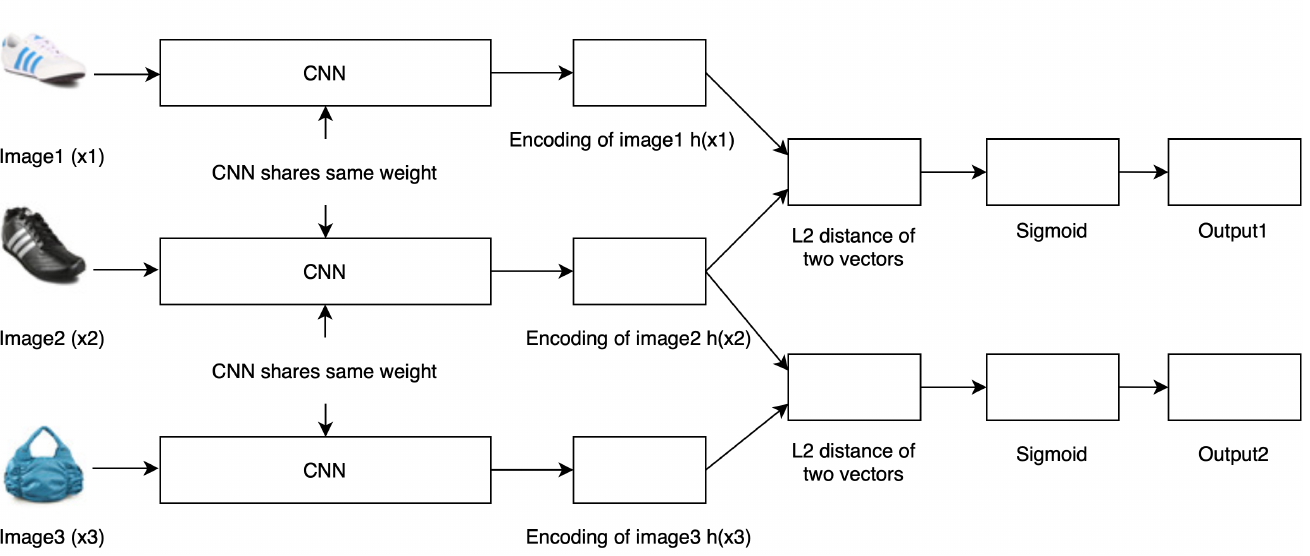
Figure 2. Triple Siamese network.